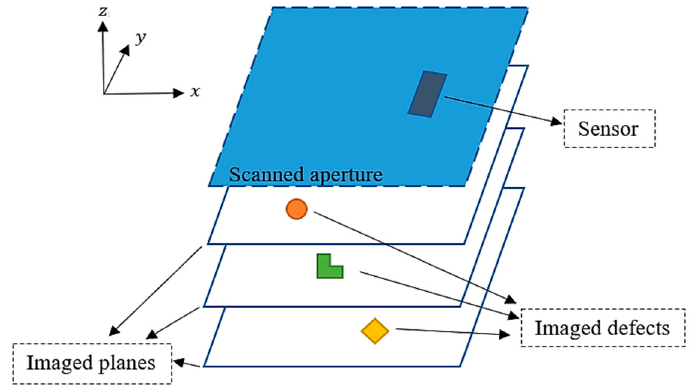
Figure 1. Illustration of the near-field microwave holographic imaging setup.